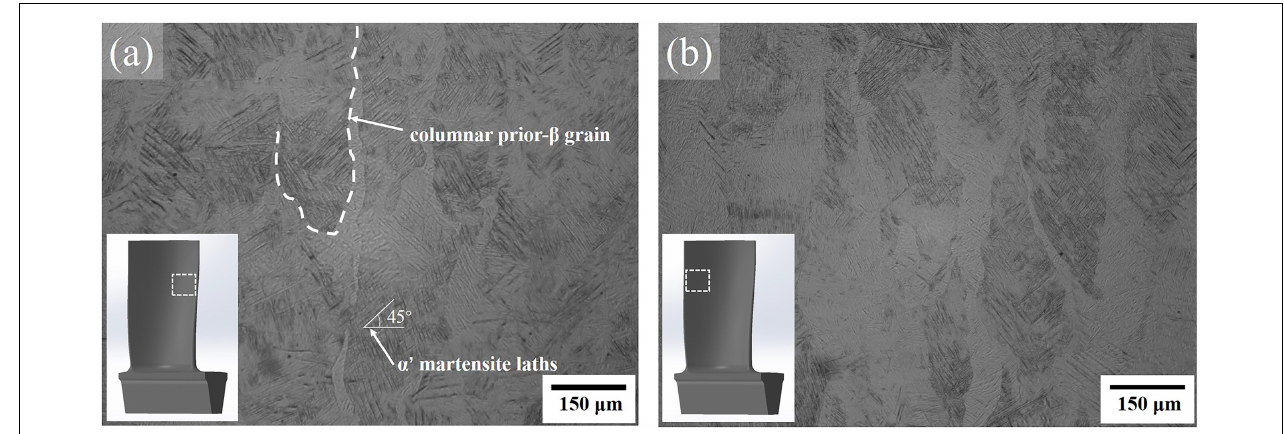
FIGURE 3 | Optical microscopy (OM) images of the longitudinal section of SLM Ti6Al4V blade. (a) The leading edge, (b) the trailing edge.